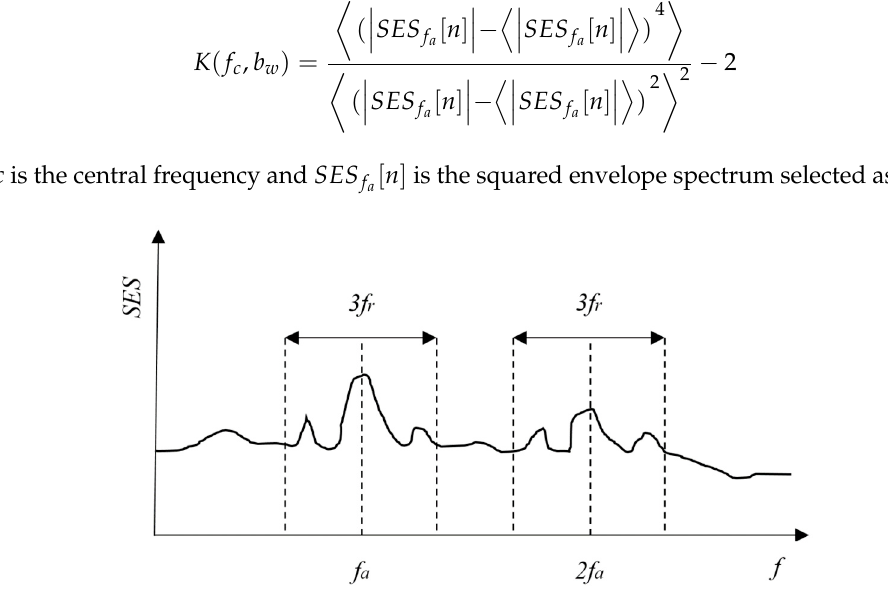
Figure 3. The part of squared envelope spectrum (SES) used to calculate the kurtosis.